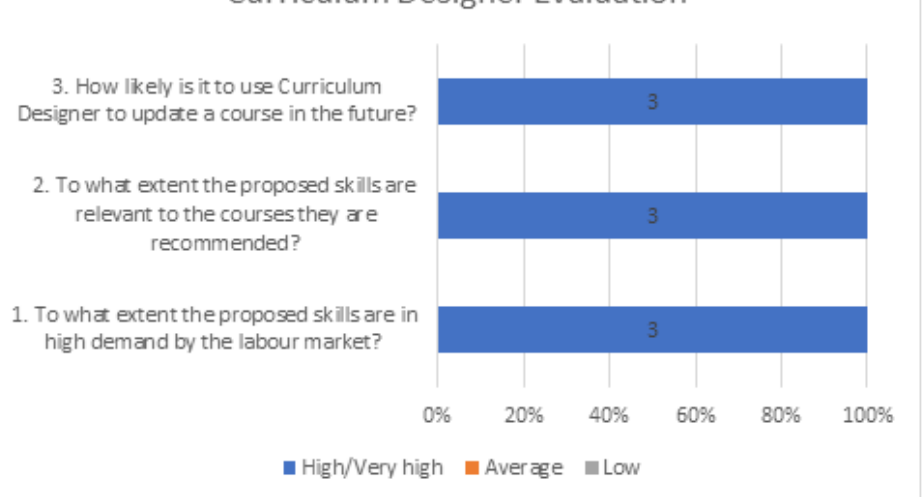
Figure 16. Curriculum Designer evaluation by professors.